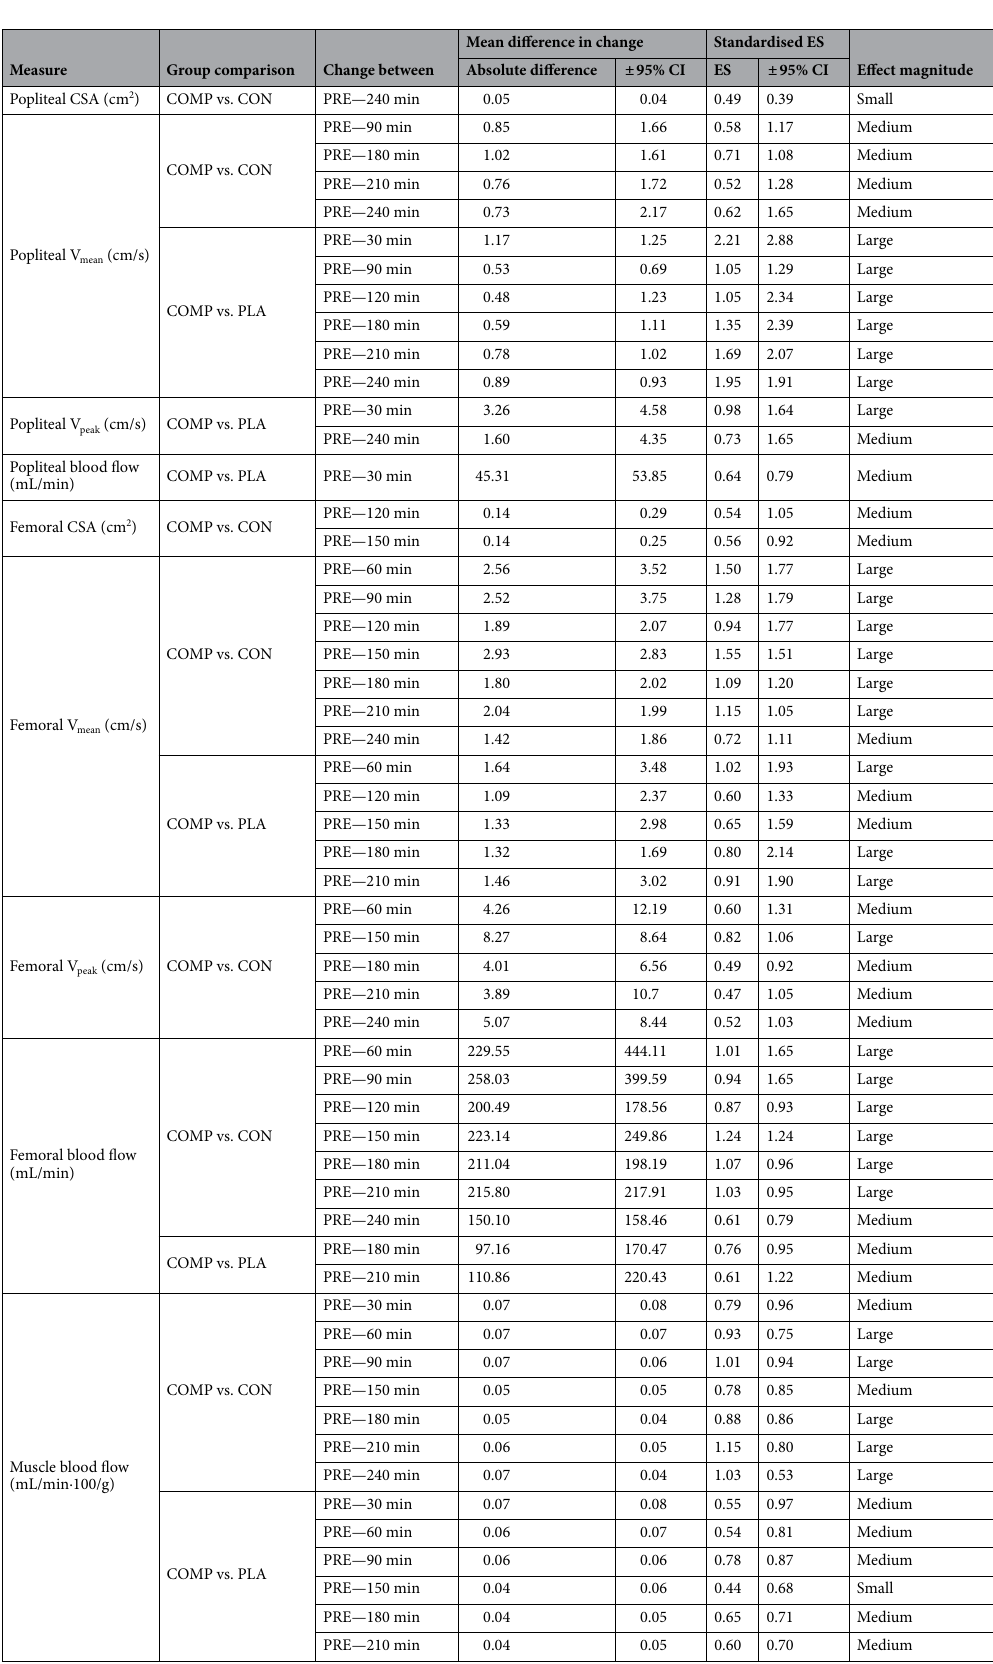
Table 1. Summary of all between-group effects for muscle blood flow and markers of venous